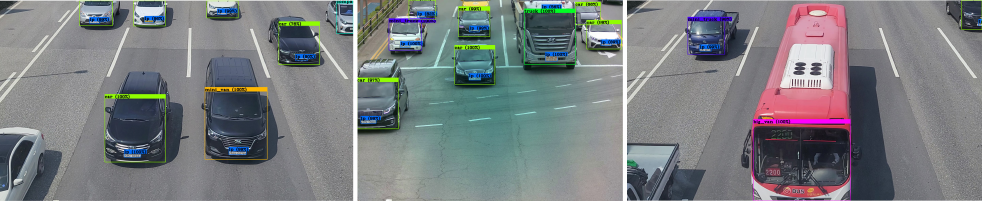
Figure 13. Examples of successfully detected vehicle types ( car , mini van , mini truck , truck , bus ) with the VT_LP detector in phase 1.